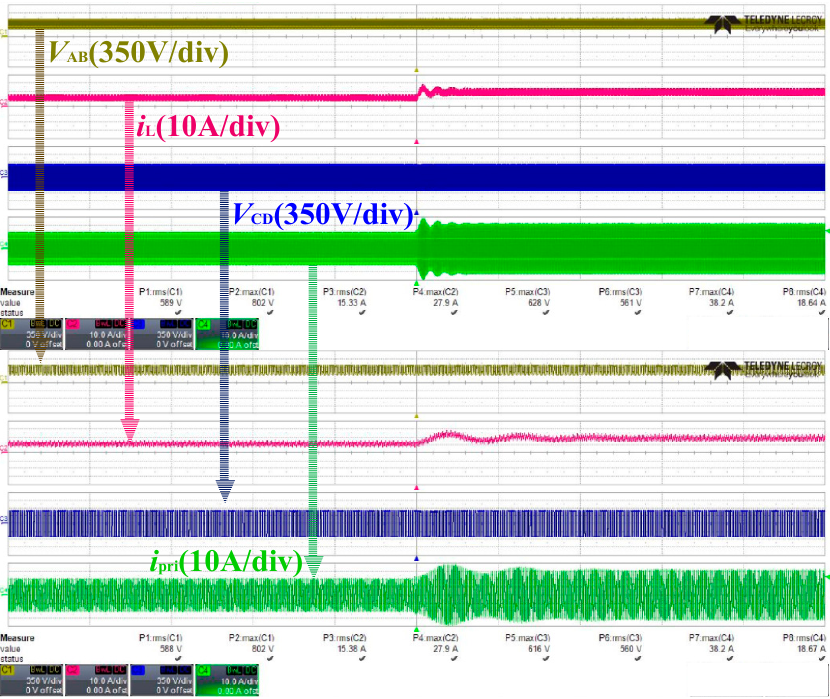
Figure 24. Transient waveforms during a step-down of the resistive load from R 0 = 27 Ω to R 0 = 16 Ω .